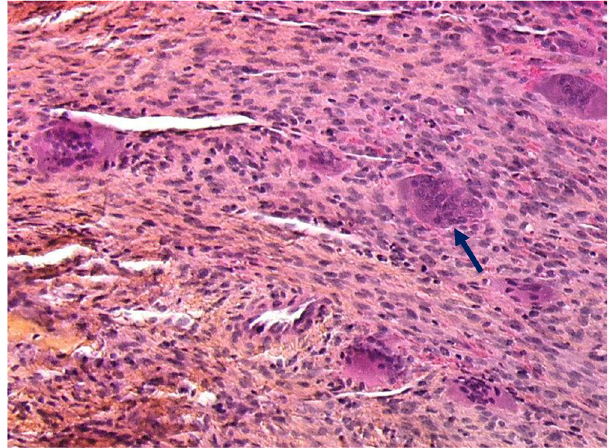
Fig. 3. Histological slide coloured with hematein eosin safran (HES) (magni fi cation (cid:1) 40) showing numerous multinucleated giant cells (black